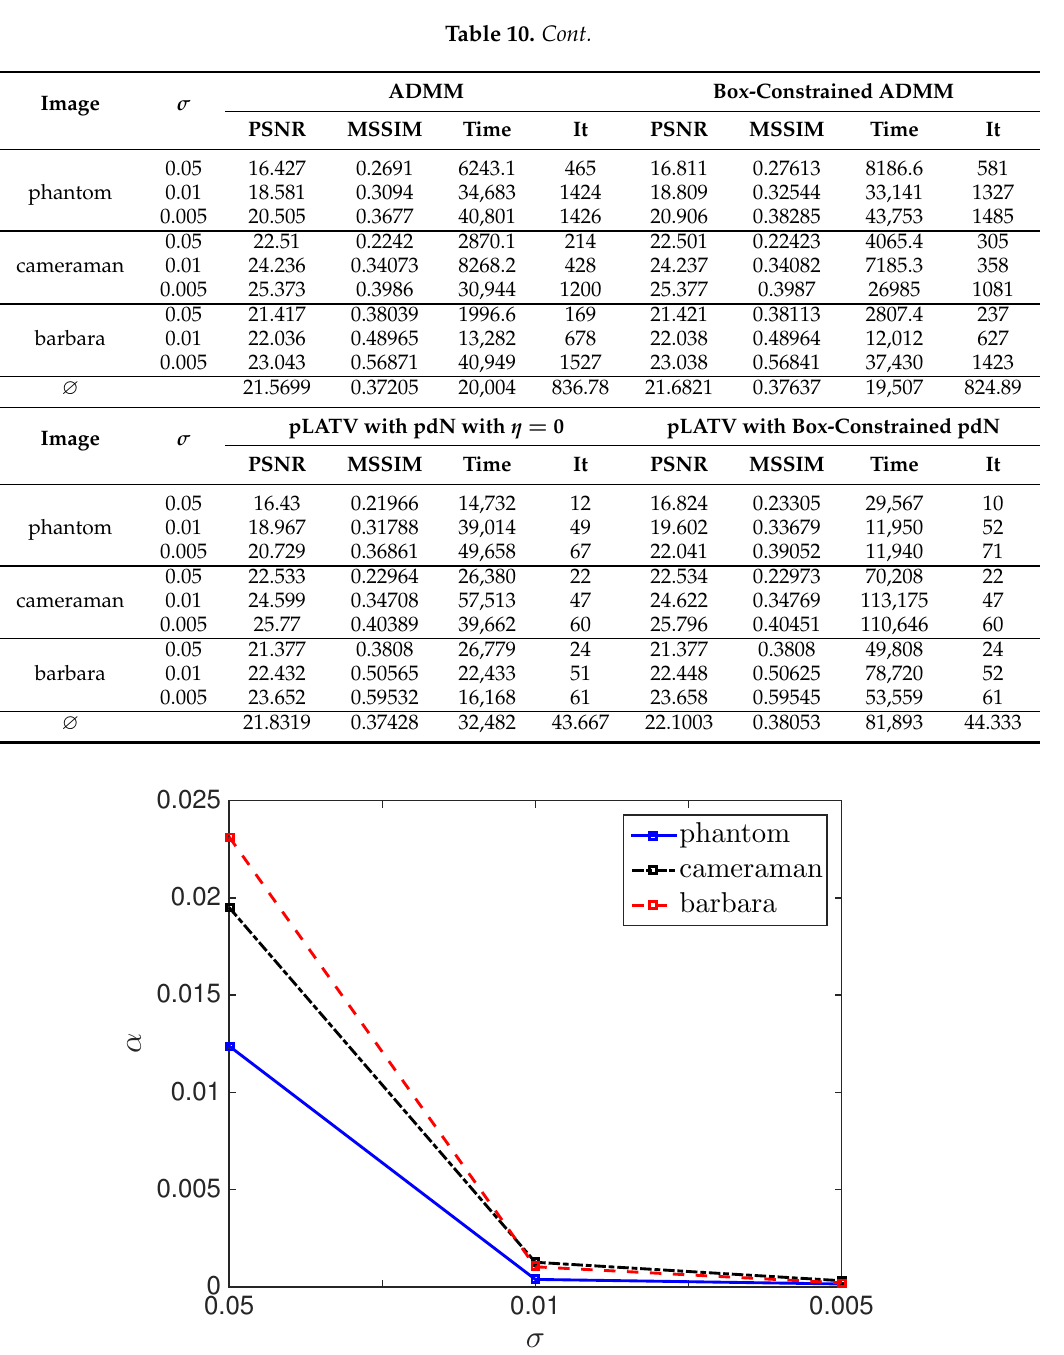
Figure 7. Regularization parameter versus noise-level for the box-constrained pAPS in image